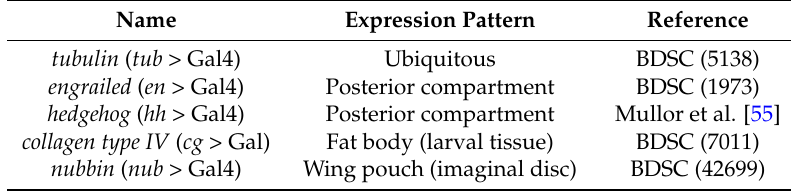
Table 1. List of Gal4 lines used.